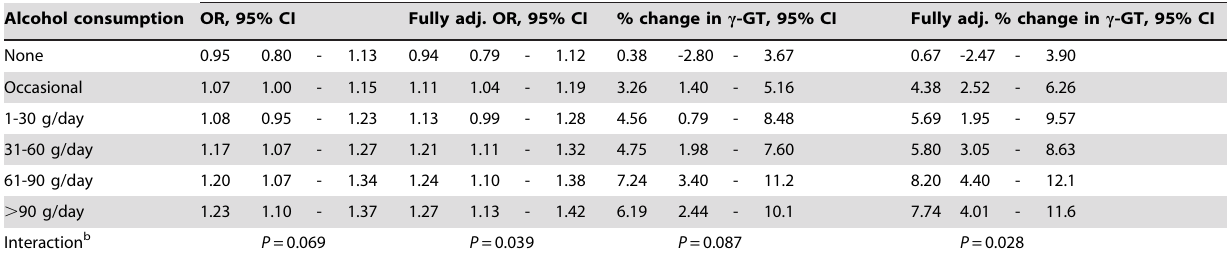
Table 4. Regression of c -GT and smoking, by alcohol consumption